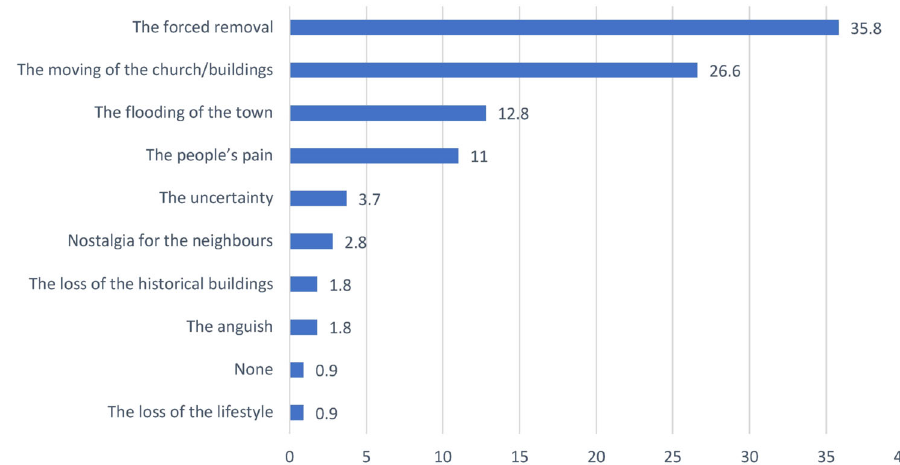
Fig. 9 Local community. Inhabitants of New Portomarín. What memory has had the biggest impact on